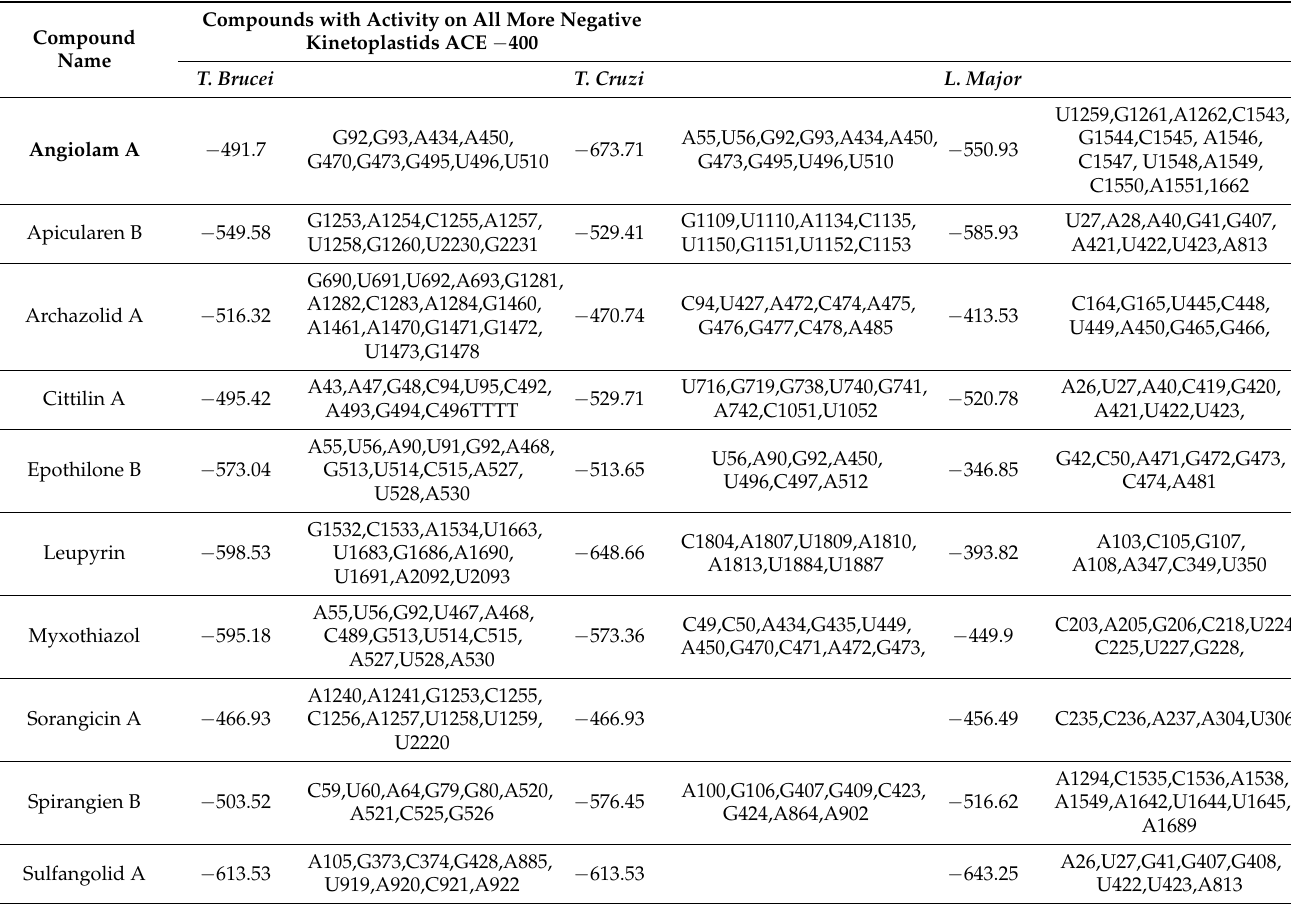
Table 4. Showing docking and binding results of the best pose compounds with activity on all more negative kinetoplastids ACE −